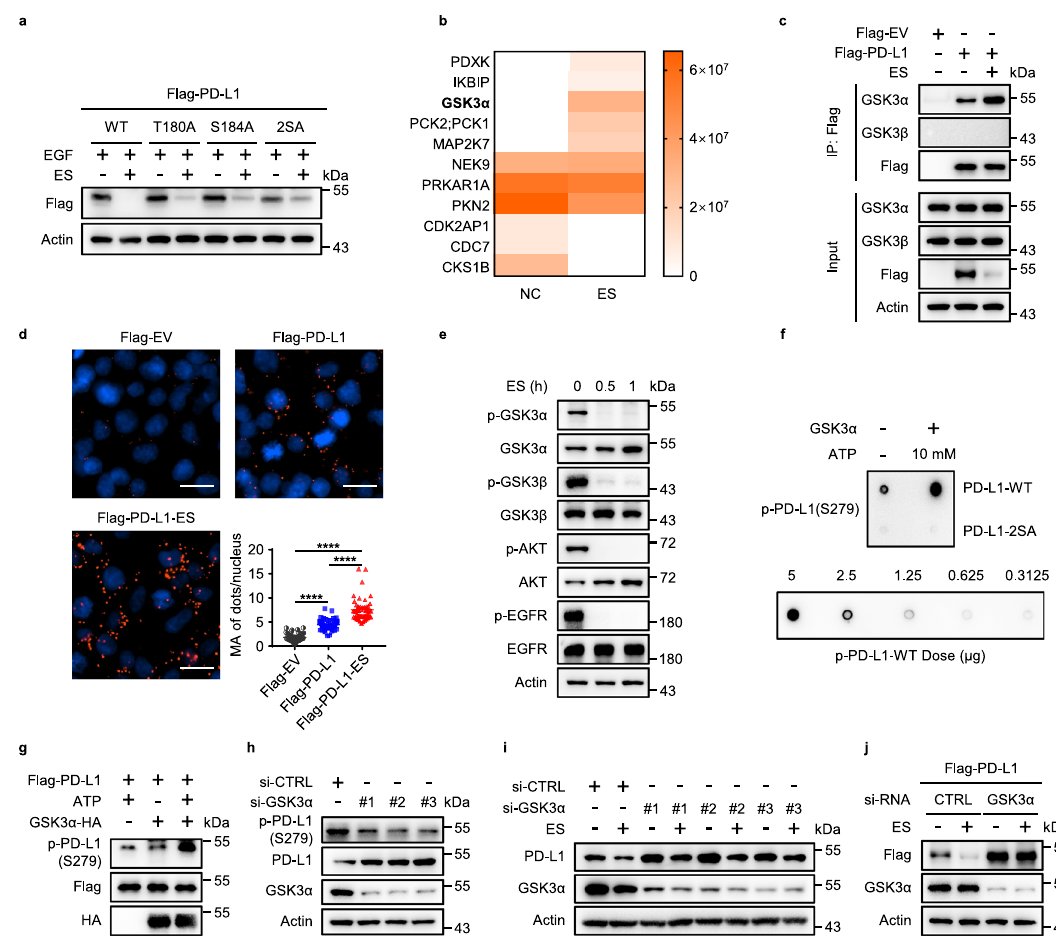
Fig. 3 GSK3 α -mediated phosphorylation of PD-L1 promotes PD-L1 degradation. a Immunoblots of PD-L1 (anti-Flag) in HEK293T cells transfected with Flag- PD-L1 (WT) or Flag-PD-L1 (mutants) following treatment with 25ng/mL EGF and/or 10 μ M ES-072 for 48h, 2SA represents T180A/S184A. b HEK293T cells were transfected with Flag-PD-L1 and treated with ES-072 (10 μ M) for 48h. Proteins that co-immunoprecipitated (Co-IP) with PD-L1 were analyzed by mass spectrometry. Kinases and kinase-related proteins are shown in heatmap. c Co-IP analysis for the interaction of GSK3 α /GSK3 β and PD-L1 in HEK293T cells transfected with Flag-PD-L1 and treated with or without 10 μ M ES-072 for 12h, Flag-tagged empty vector (Flag-EV) was transfected as a negative control. d Proximity ligation assay (PLA) analysis for the interaction of GSK3 α and PD-L1 in HEK293T cells treated as c . PLA signals are shown in red and the nuclei in blue; scale bar, 20 μ m. Quanti fi cation for the mean area (MA) of PD-L1/GSK3 α PLA speckles is indicated by scattergram. Data represent means±SEM, n = 50, **** P <0.0001. e Immunoblots of p-GSK3 α , GSK3 α , p-GSK3 β , GSK3 β , p-AKT, AKT, p-EGFR, and EGFR in H1975 cells treated with 10 μ M ES-072 for indicated times. f In vitro GSK3 α kinase assay was performed in the presence or absence of ATP. The phosphorylation of PD-L1 peptides (PD-L1-WT/2SA) was detected by dot blot with anti-p-PD-L1 (Ser279) antibody, p-PD-L1 peptides were synthesized as a positive control. g In vitro GSK3 α kinase assay was performed in HEK293T cells transfected with Flag-PD-L1 and GSK3 α -HA. Total cell lysates were immunoprecipitated with anti-Flag or anti-HA. The phosphorylation of PD-L1 by GSK3 α was detected using an anti-p-PD-L1 (Ser279) antibody. h Immunoblots of p-PD-L1, PD-L1, and GSK3 α in H1975 cells transfected with GSK3 α -siRNAs. i Immunoblots of PD-L1 and GSK3 α in U937 cells transfected with GSK3 α -siRNAs and treated with or without 10 μ M ES-072 for 24h. j Immunoblots of PD-L1 (anti-Flag) and GSK3 α in HEK293T cells transfected with Flag-PD-L1 following treatment with GSK3 α -siRNA and treated with or without 10 μ M ES-072 for 24h. Source data are provided as a Source Data fi